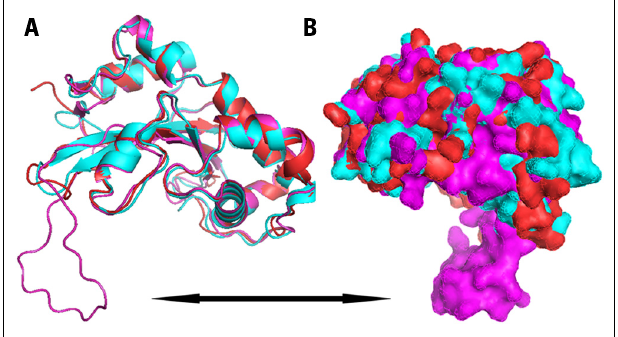
FIGURE 2 | Ribbon diagram (A) and surface representation (B) of modeled structure of almond S f -RNase (magenta), S 8 -RNase (cyan), and S 23 -RNase (red), showing secondary structural elements and surfaces. Black arrow indicates the “long loop” found in the S f model.